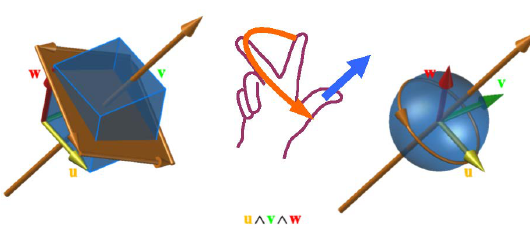
Figure 31: The geometric interpretation of the exterior product of three vectors u , v , w as an oriented volume compared with the right-hand rule. The actual shape is